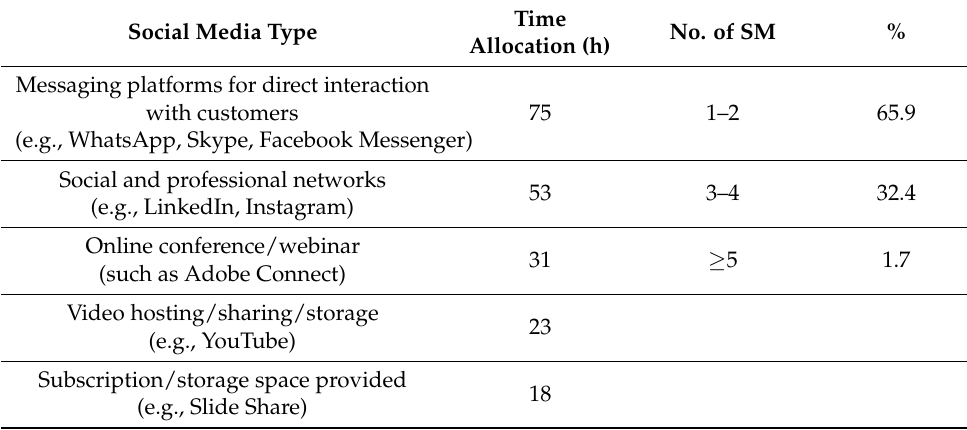
Table 5. Types of social media used by